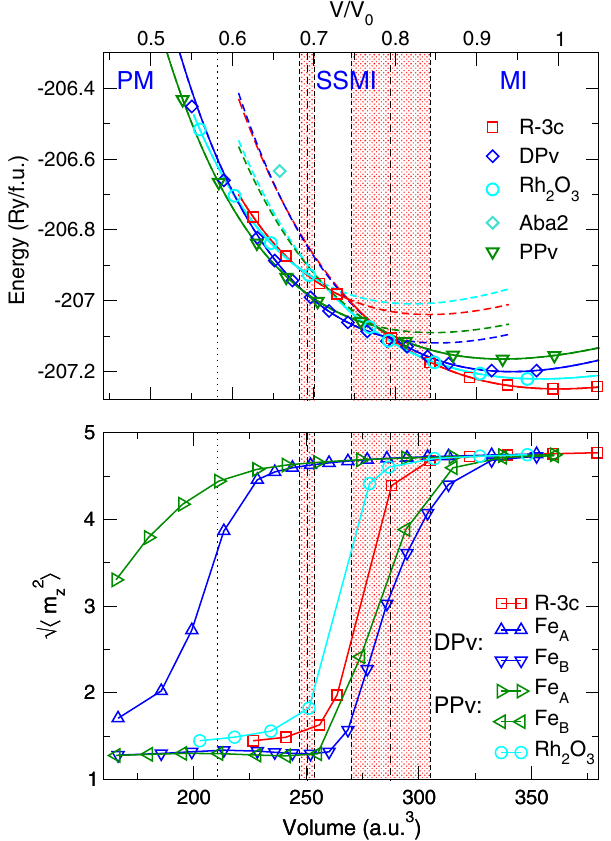
ffiffiffiffiffiffiffiffiffiffi p h ˆ m 2 i of z ¯3 c ) MI phase